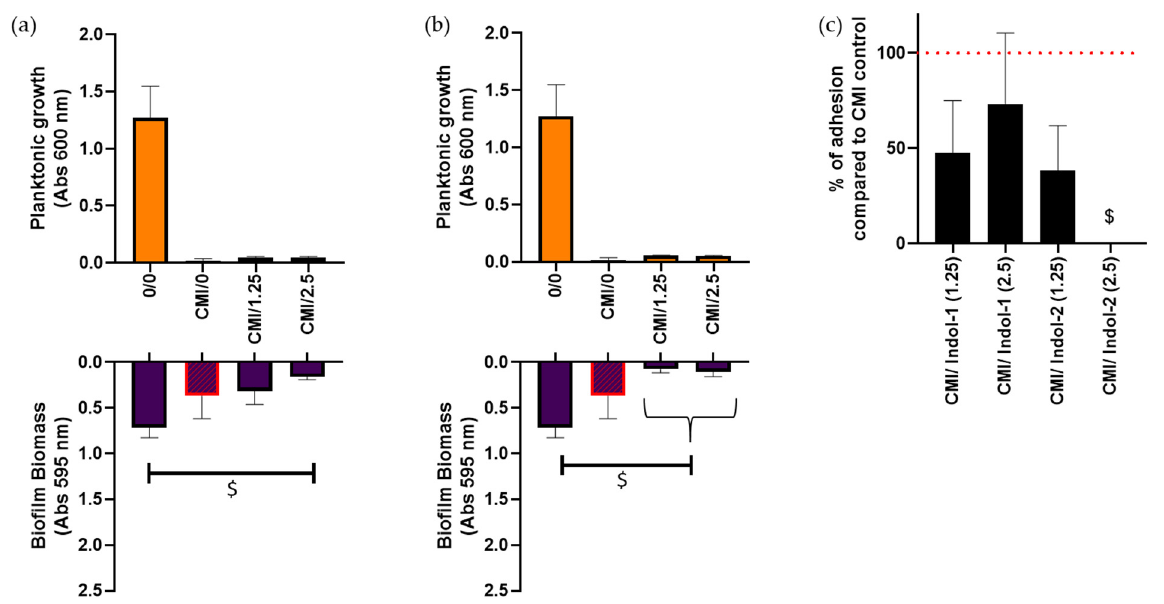
Figure 3. Ciprofloxacin MIC treatment combined with Indol-1 and Indol-2 molecules against P. aeruginosa . Ciprofloxacin concentration is annotated in first position and indoquinoline in second position in abscissa legend. ( a , b ) Planktonic growth and biofilm biomass after 24 h: ( a ) Indol-1 compound and MIC of ciprofloxacin (0.63 µg/mL); ( b ) Indol-2 compound and MIC of ciprofloxacin (0.63 µg/mL). MIC of ciprofloxacin appeared in red square. ( c ) Percentage of adherent cells after indoloquinolines + MIC of ciprofloxacin rationalized to the quantity of adherent cells after MIC of ciprofloxacin treatment alone. $: p < 0.05, significant vs. control.